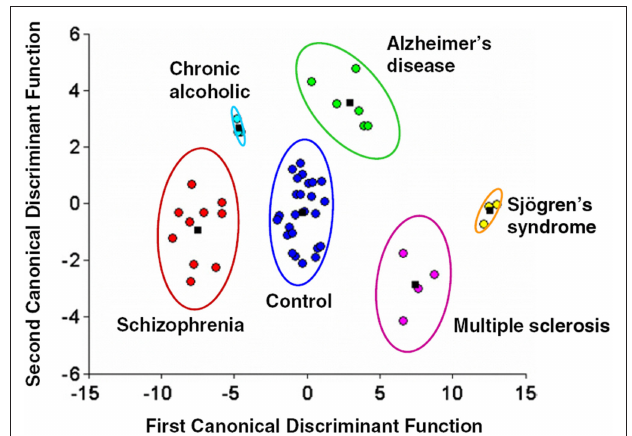
Figure  | results from a linear discriminant classification analysis applied to Meg resting-state functional connectivity (partial cross- correlation) data across multiple groups, including both controls and patients with schizophrenia. Even from MEG recordings when no task is being performed, the classifier was able to discriminate between the different populations, with no overlap seen between the control and schizophrenia groups. These differences suggest that resting-state functional connectivity derived from MEG data can be a robust indicator of clinical diagnosis. Reproduced, with permission, from Georgopoulos et al.